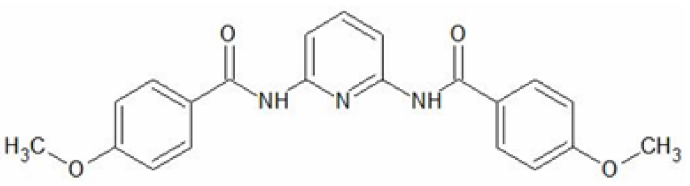
Figure 1. Structure of 2,6-bis(4-methoxybenzoyl)-diaminopyridine (C 21 H 19 N 3 O 4